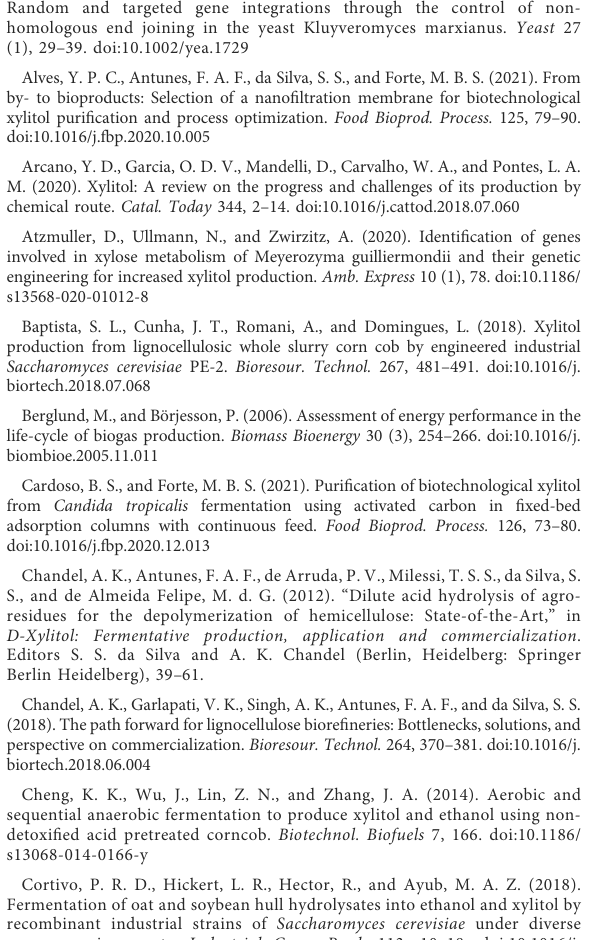
SUPPLEMENTARY FIGURE S1 Plasmids schema used in this study. SUPPLEMENTARY FIGURE S2 Xylitol puri fi cation fl ow chart in this